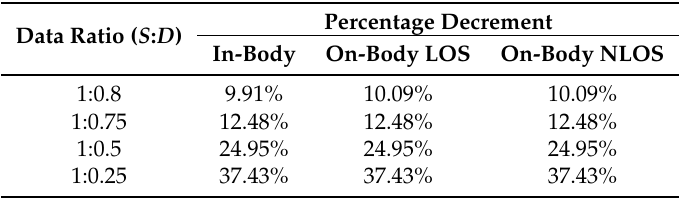
Table 5. Unequal data over relay